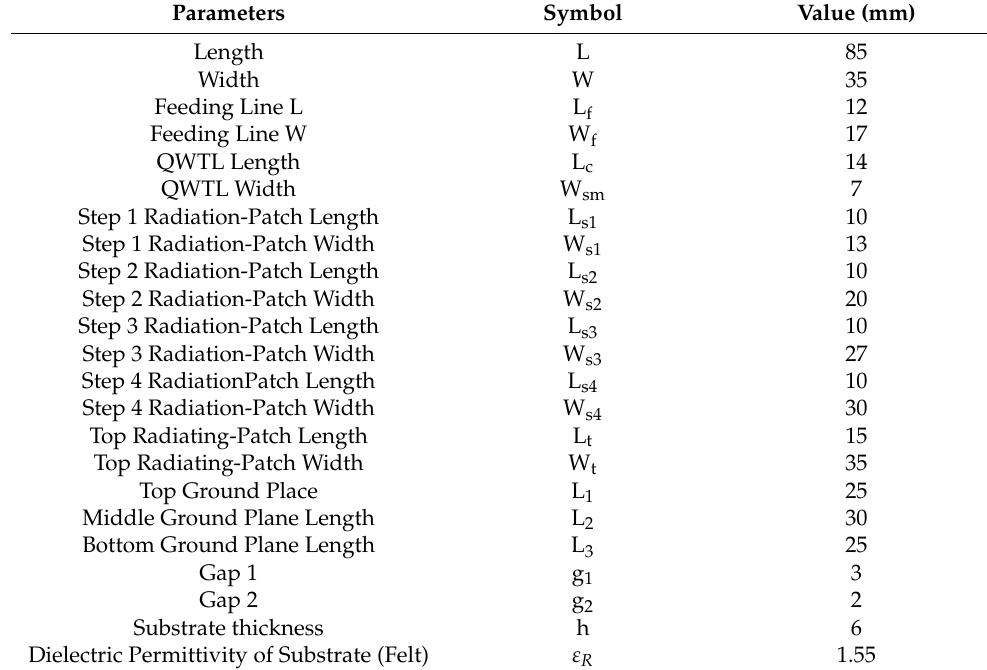
Table 1. Antenna-design parameters.